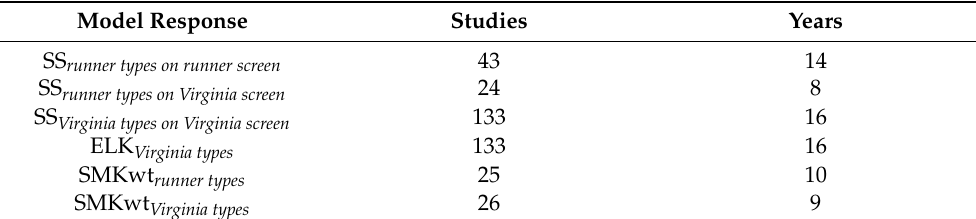
Table 1. Number of studies and years within datasets for models to predict proportion sound splits (SS), proportion extra large kernels (ELK), and sound mature kernel (SMK) wt (g) as functions of 100 SMK wt (SS and ELK models) or pod wt (g).